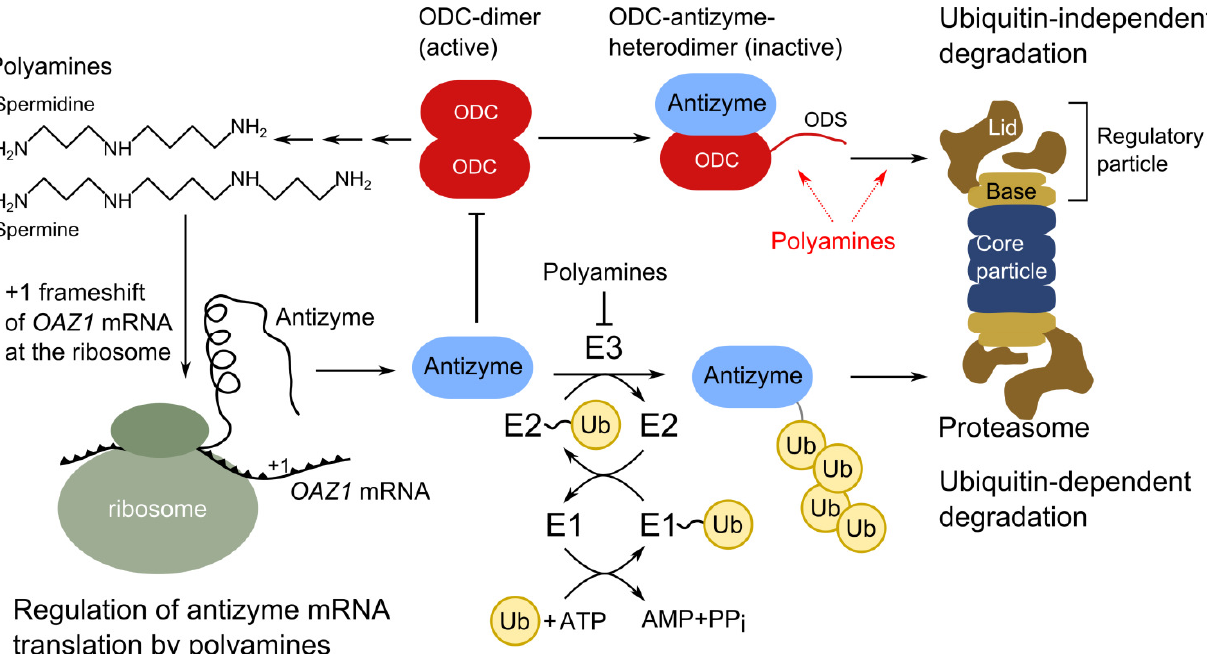
FIGURE 2: Regulation of ornithine decarboxylase activity by polyamines in yeast. Ornithine decarboxylase (ODC) is an enzyme that catalyz- es the rate-limiting commitment step in polyamine biosynthesis. It is a dimer in its active form and is inhibited by antizyme, which binds to ODC in a one-to-one complex as heterodimer. The yeast gene encoding antizyme is called OAZ1 , which produces an mRNA with two ORFs. To produce the full protein, a +1 frameshift during antizyme mRNA translation is necessary at the ribosome, which is induced by the polyamines spermidine or spermine. Antizyme does not have to be present in large amounts to inhibit ODC activity, as binding of ODC by antizyme leads to presentation of the ODC degradation sequence (ODS), which induces proteasomal degradation. This step is directly promoted by polyam- ines. Polyamines could increase ODS presentation, enhance binding of antizyme to proteasomes, or both (dashed red arrows). Antizyme itself escapes destruction by the proteasome, thus even low levels of antizyme catalyze degradation of ODC. Antizyme stability is regulated by polyamines as well; the presence of polyamines reduces antizyme proteolysis by an ubiquitin-dependent proteasomal degradation pro- cess. The latter depends on the ubiquitin-activating enzyme (E1) Uba1, the ubiquitin–conjugating enzymes Ubc4 and Ubc5 (E2), and an uni- dentified ubiquitin-protein ligase (E3). Overall, polyamines influence ODC activity threefold; they enhance ODC proteolysis, increase an- tizyme levels by promoting its biosynthesis and inhibit its destruction, which provides a negative feedback loop for ODC regulation by poly-